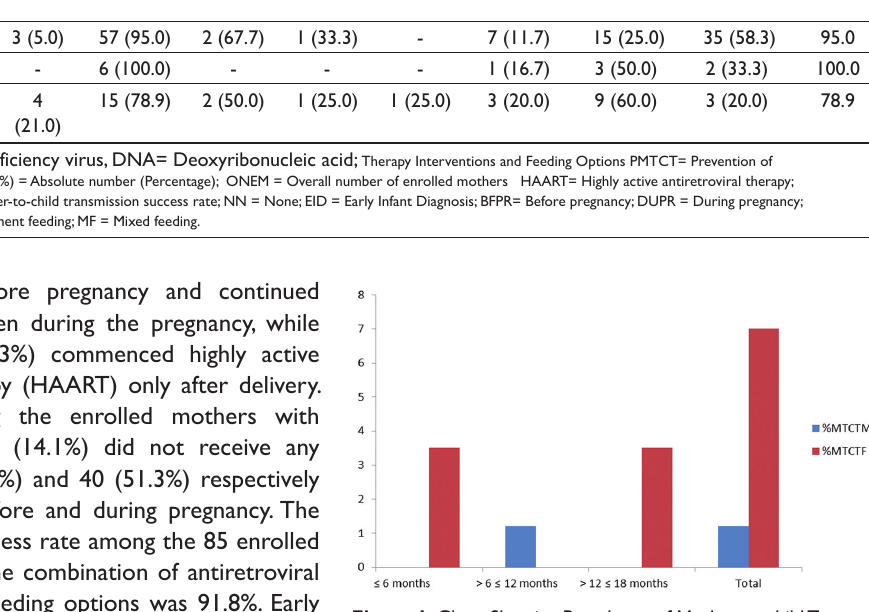
Figure 1: Chart Showing Prevalence of Mother-to-child Trans- mission of HIV-1 among Exposed Male and Female Infants Born to Enrolled Mothers. %MTCTM = Percentage of Mother-to-child Transmission of HIV-1 among Exposed male infants; % MTCTM = Percentage of Moth- er-to-child Transmission of HIV-1 among exposed female